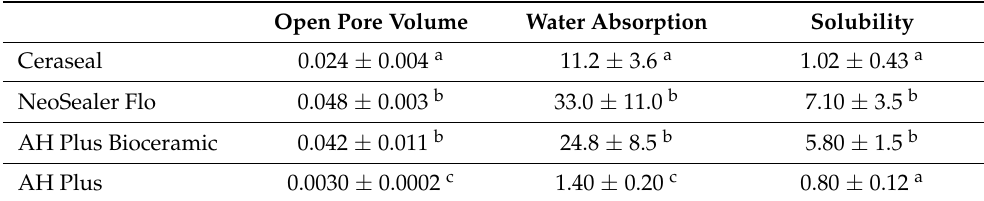
Table 3. Open pore volume (cm 3 , mean ± SD; n = 6), water absorption and solubility (%, mean ± SD; n = 6) of tested sealers. Analyses were performed on set materials (+100% of final setting time). Different superscript letters (vertical row) indicate statistically significant differences ( p < 0.05) among materials.